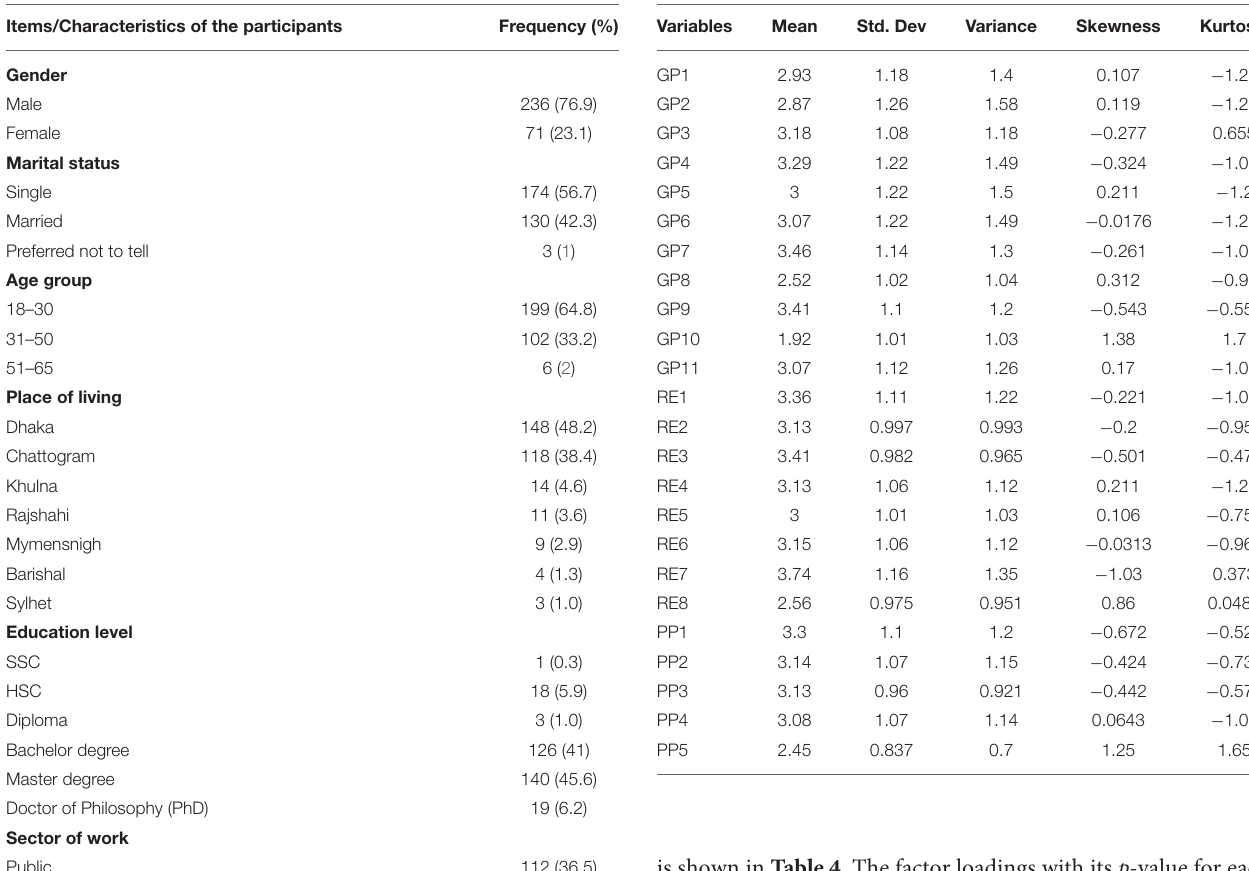
TABLE 2 | Socio-demographic characteristics of the